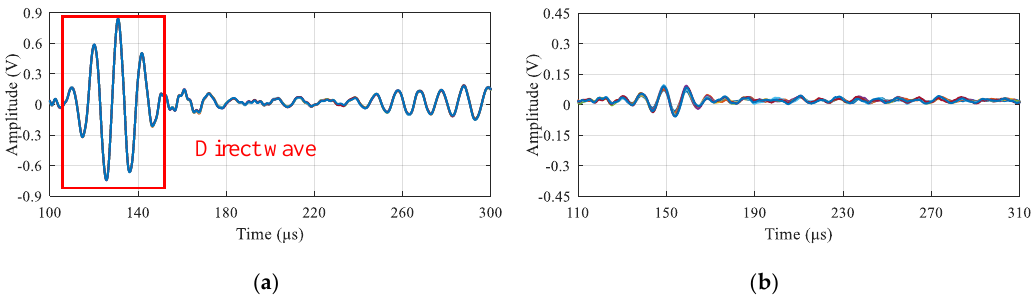
Figure 6. Acquired 8 GW signals of paths 2-6 at different temperatures. ( a ) Low temperature 50 °C ( b ) High temperature 150 °C.